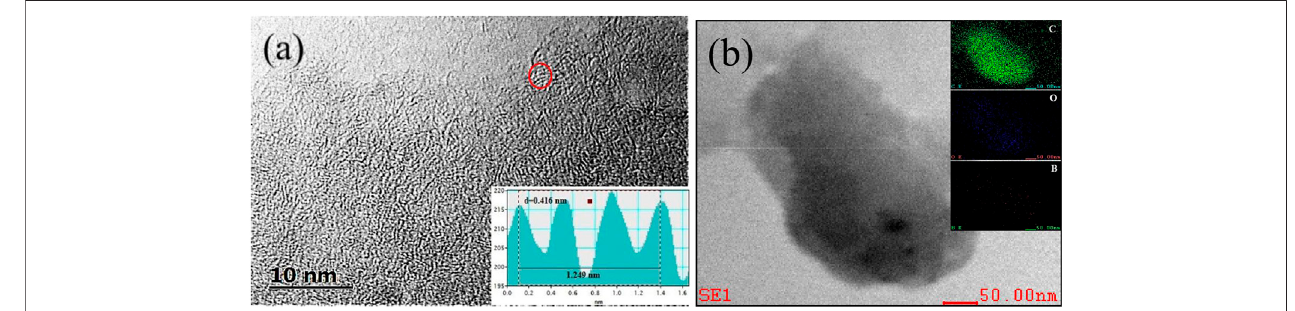
FIGURE 2 | (A) HRTEM image and (B) EDS map of